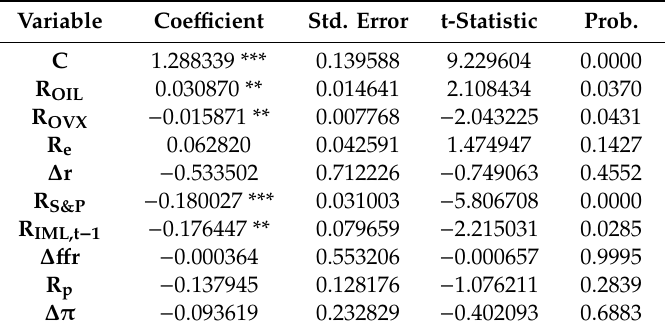
Table 9. OLS regression results (full